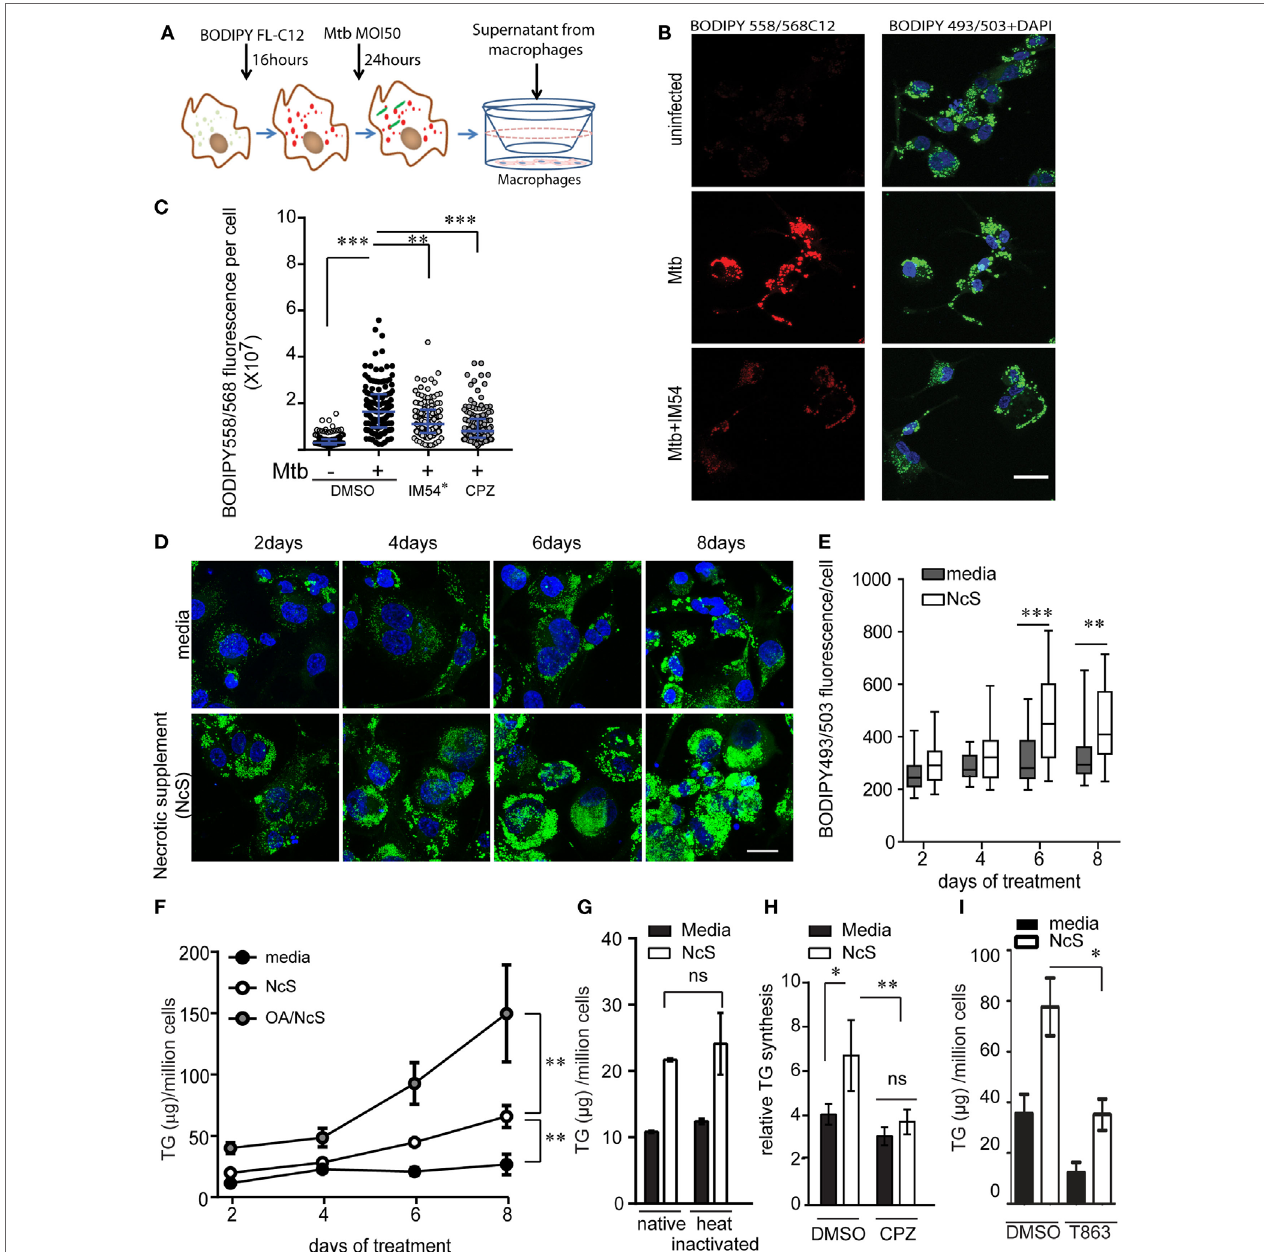
FigUre 5 | Ex vivo model of necrosis-associated foamy macrophages. (a) Schematic representing experimental setup for supernatant transfer from BODIPY558/568C12 labeled infected THP1 macrophages. (B) BODIPY 493/503 and DAPI staining in THP1 macrophages treated with supernatant from uninfected or Mycobacterium tuberculosis -infected THP1 macrophages labeled with BODIPY558/568C12 prior to infection. Scale bar = 25 μ m. (c) Quantification of BODIPY558/568 fluorescence per recipient cell from experiment shown in (a) . IM54* indicates treatment of donor cells with IM54 during infection while chlorpromazine (CPZ) was added to recipient cells. DMSO was used as a vehicle control at 0.1% vol/vol. Data are from three independent experiments, with approximately 100 cells per group. (D) BODIPY493/503 (green) and DAPI (blue) stained THP1 macrophages at days 2, 4, 6, and 8 post treatment with media or necrotic cell supplement (NcS). Scale bar = 25 μ m. (e) Quantification of total cellular BODIPY493/503 signal from a representative experiment. (F) TG estimation from THP1 macrophages post 2, 4, 6, and 8 days of differentiation. Gray circles represent NcS prepared from oleic acid pre-treated cells. 150 µM bovine serum albumin-conjugated oleic acid was added to cells 48 h prior to NcS preparation. Data are mean ± SEM from three independent experiments. (g) TG estimation from THP1 macrophages at 8 days post differentiation with normal media, NcS, or heat-inactivated normal media or heat inactivated NcS. Data are mean ± SD from triplicate wells. Data are representative of two independent experiments. (h) TG synthesis over 2 days in THP1 macrophages in response to heat inactivated NcS or media in the presence of DMSO or chlorpromazine (CPZ). Data are mean from three independent experiments, normalized to 5 h time point for normal media. (i) TG estimation in macrophages exposed to media or NcS after 8 days of treatment in the presence of DMSO (vehicle control) or T863 (10 µM). Data are mean ± SEM from three independent experiments. Kruskal–Wallis test derived p -values are shown in (c,e) . Linear regression analysis for slopes was done in (F) . T -test derived p -values are indicated in (e,g–i) (*** p < 0.001, ** p < 0.01, * p < 0.05, ns, not